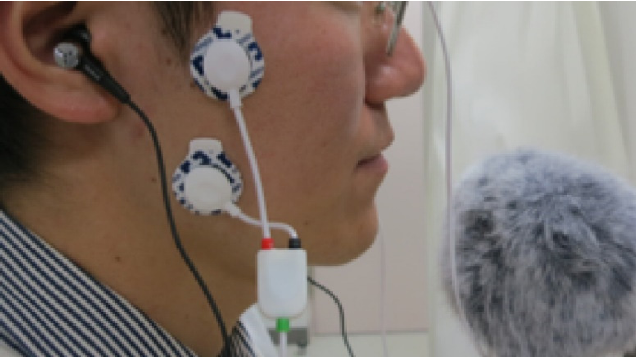
Figure 5. Experimental setup of the EMG probes, binaural microphones, and sound recorder with a windproof bore. EMG, electromyography.